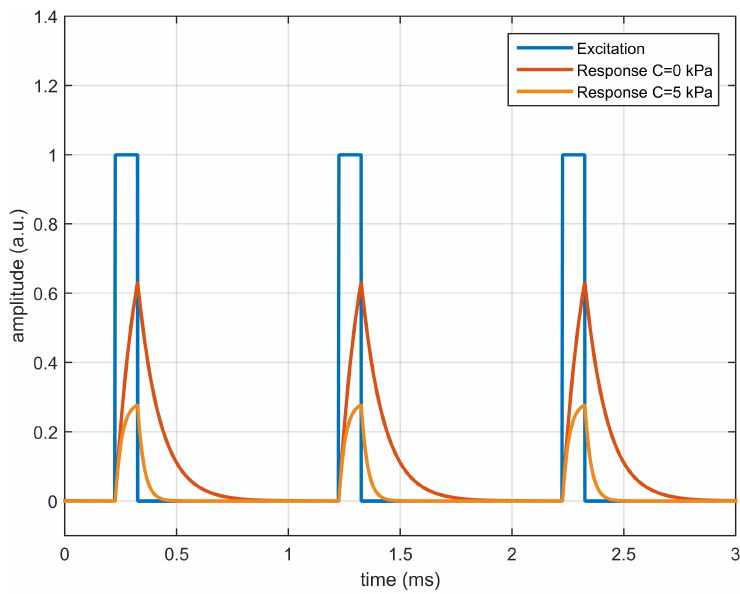
Figure 1. Simulated response of a first order luminescent system with M 0 = 1, τ 0 =100 µ s, k = 0.5 (kPa) − 1 excited with rectangular pulses of amplitude 1.0 a.u. presented at 1 kHz with 10% duty cycle, for quencher concentrations C = 0 kPa and C = 5